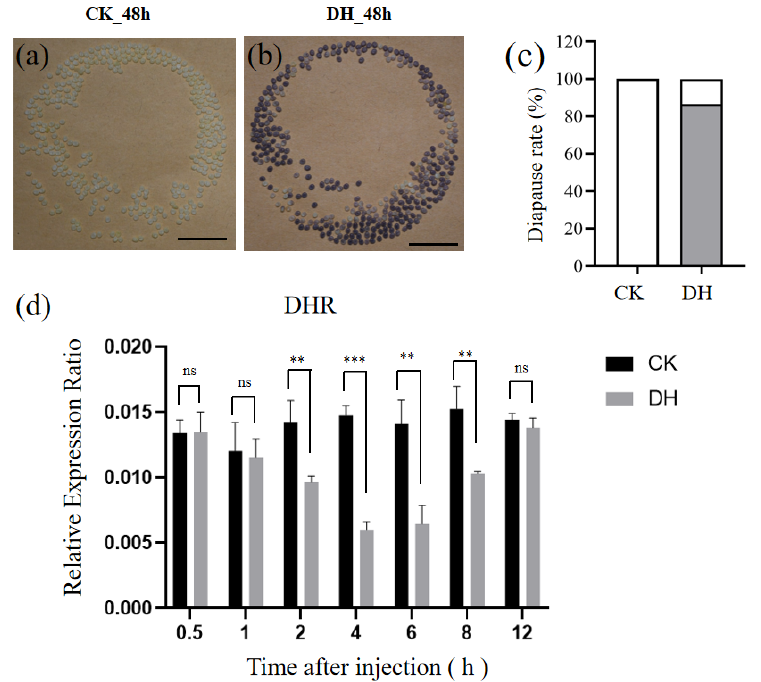
Figure 1. DH induces diapause in the Nistari strain. ( a – c ) The typical egg batches 48 h after oviposition from each distilled water-injected (CK_48h) and DH-injected (DH_48h) silkworm in the Nistari strain. Scale bar: 1 cm. ( d ) The expression patterns of BmDHR . qRT-PCR was used to detect the expression levels of BmDHR gene in the ovary at 0.5 h, 1 h, 2 h, 4 h, 6 h, 8 h, and 12 h. B. mori ribosomal protein gene RP49 was used as a control for normalization. The data shown are mean values ± S.E.M. ( n = 3). The asterisks indicate the significant differences with a two-tailed t -test, ** p < 0.01; *** p < 0.0001. The ns indicate the no significant